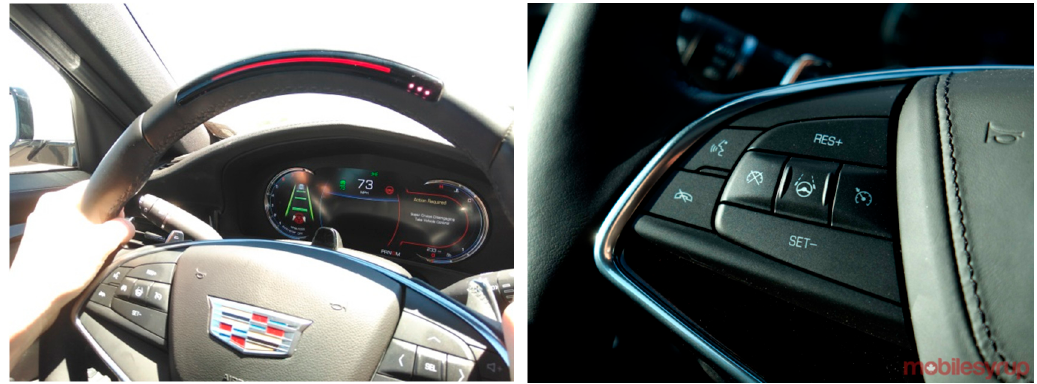
Figure 4. HMI elements of the GM Supercruise system.